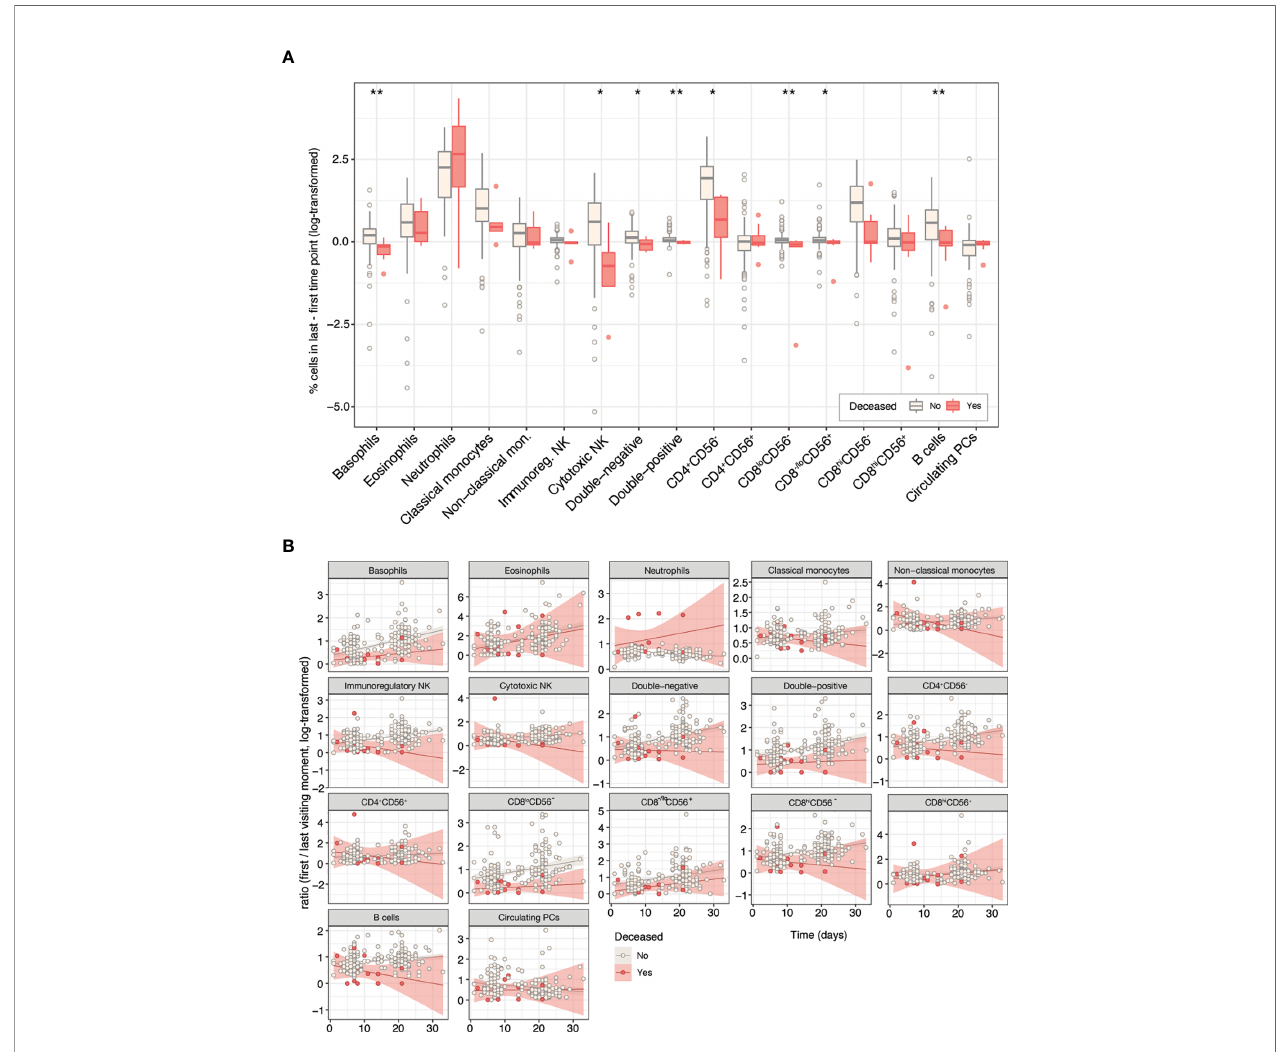
FIGURE 5 | Divergent immune response trajectories in patients with COVID-19 with longitudinal immune monitoring who had favorable (n=158) or fatal (n=9) outcomes. (A) Absolute variations in percentages of immune cell-types from fi rst to last PB sampling time point, according to outcome. * P <0.05; ** P <0.01. Statistical signi fi cance was evaluated using the Kruskal – Wallis test. (B) Longitudinal relative variations in percentages of immune cell-types from fi rst through all subsequent PB sampling time points, according to